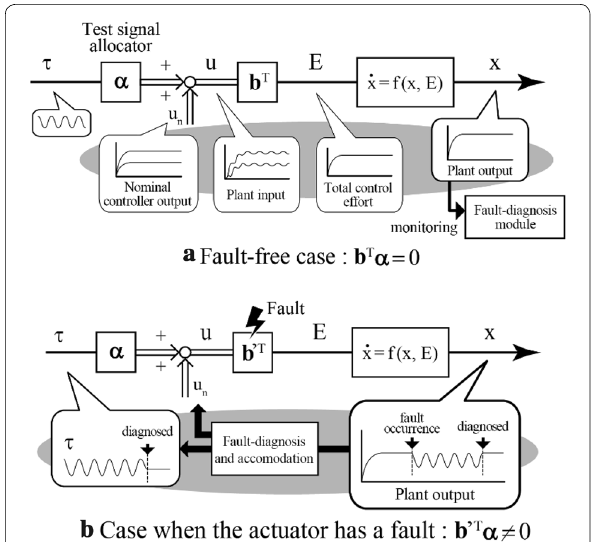
Fig. 1 Schematic of an active fault diagnosis with constant test signal allocator (an example of a two-input redundant first-order